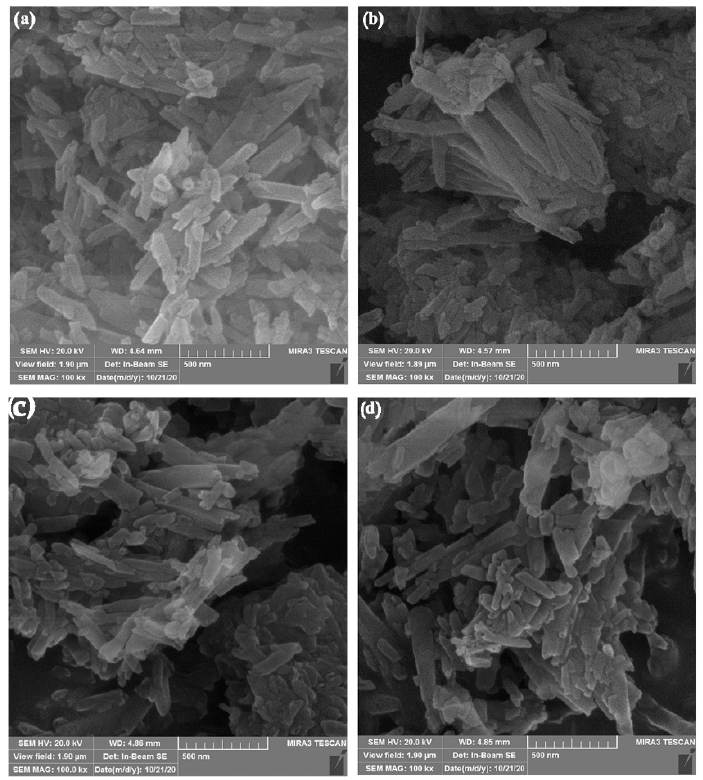
Figure 6. SEM images of silicates: ( a ) dicalcium silicate, Ca 2 SiO 4 , ( b ) magnesium silicate, Mg 2 SiO 4 , ( c ) tricalcium silicate, Ca 3 SiO 5 , and ( d ) wollastonite, CaSiO 3 . Image ProPlus6.0 software was used to examine the silicate’s grain dimensions. Synthesized Ca 2 SiO 4 (DS) has manly uniform grain dimensions of 373 ± 110 nm with the lowest degree of agglomerate formation. The opposite was found for samples Mg 2 SiO 4 (MS) and CaSiO 3 (W) samples where two groups of particles were noticed: larger particles with grain dimensions of 650 ± 50 nm (dominant) for the Mg 2 SiO 4 sample